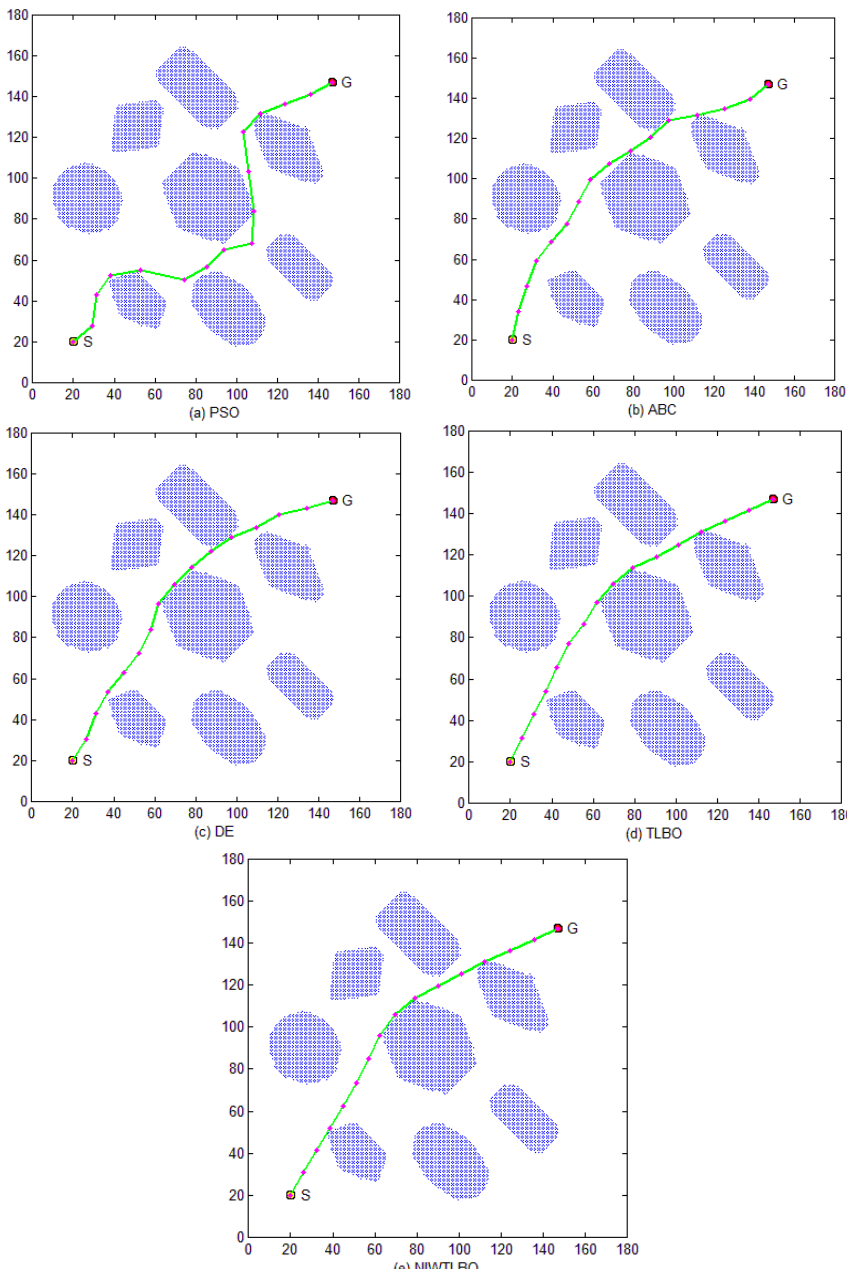
Figure 3. The optimal path map of the different algorithms. ( a ) The result of the PSO; ( b ) The result of